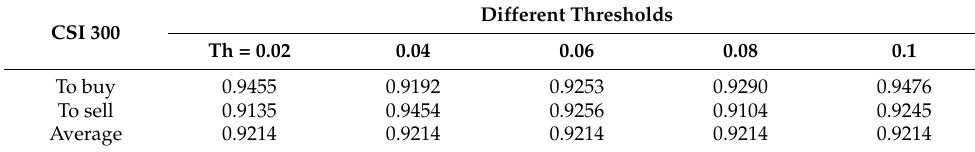
Table 6. Returns in CSI